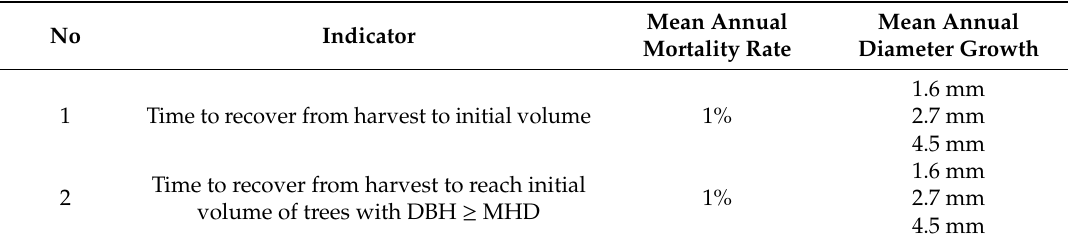
Figure 3. Growth simulation. Table 5. Simulation